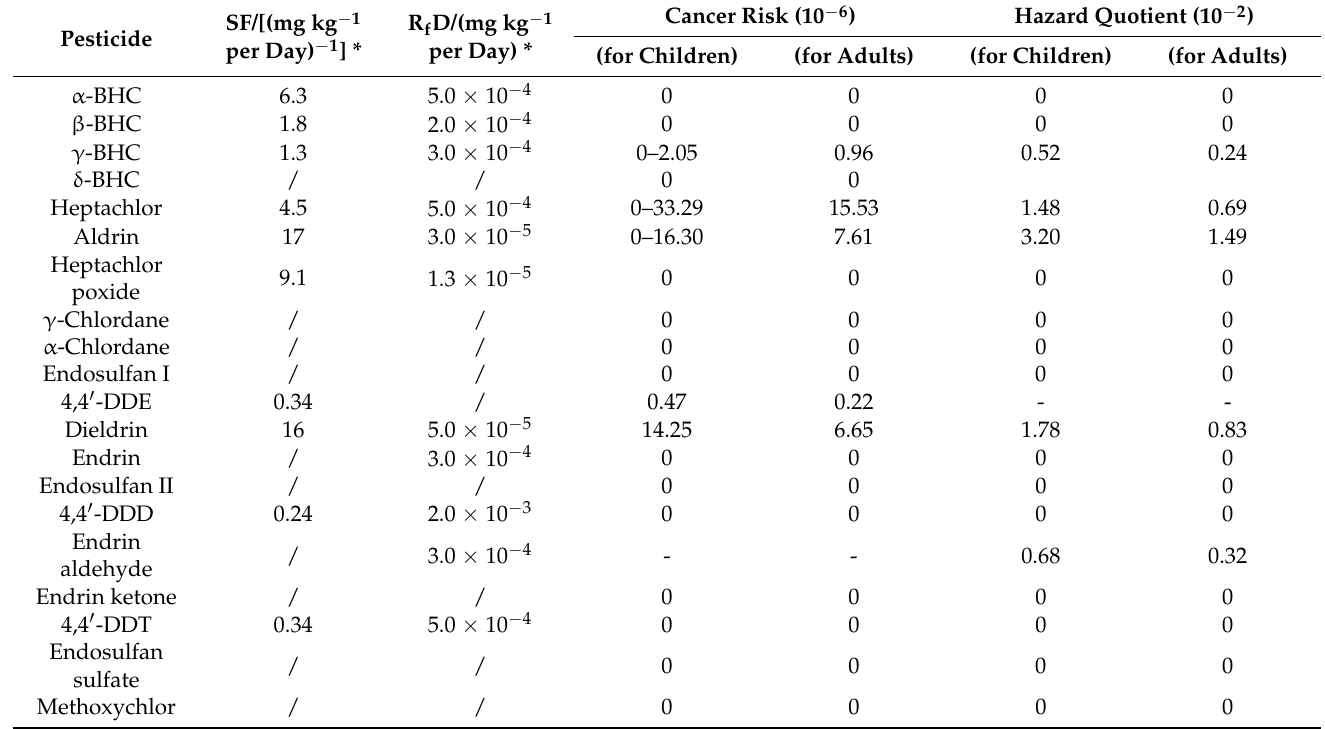
Table 1. Health risks due to organochlorine pesticides for adults and children in the Charsadda district through surface